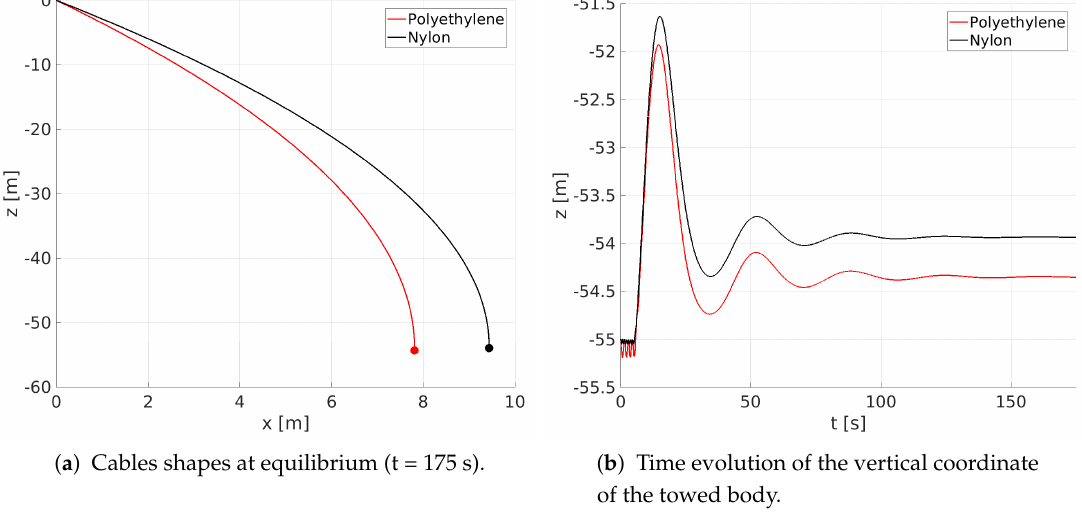
Figure 18. Submerged towed bodies towed with cables of two different materials.